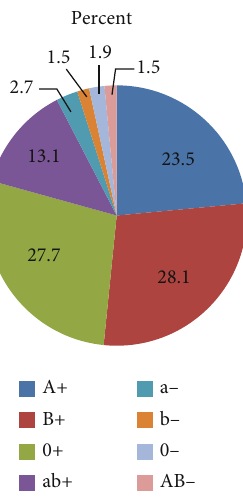
Figure 1: Blood groups of the study participants ( n = 260